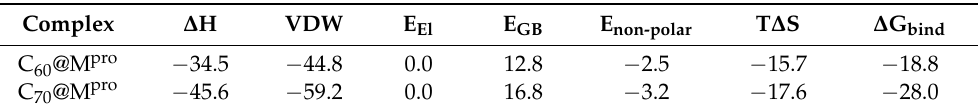
Figure 6 . Surface representation of the binding cleft of ( A ) C 60 and ( B ) C 70 in M pro . The ΔG binding between C 70 and M pro is considerably higher ( − 28.0 kcal mol − 1 ) than in the case of C 60 ( − 18.8 kcal mol − 1 ) (Table 3). Table 3. Energy components of ΔG binding (VDW, E el , E GB , and E non-polar ) for C 60 @M pro and C 70 @M pro complexes. All energies are reported in kcal mol − 1 .